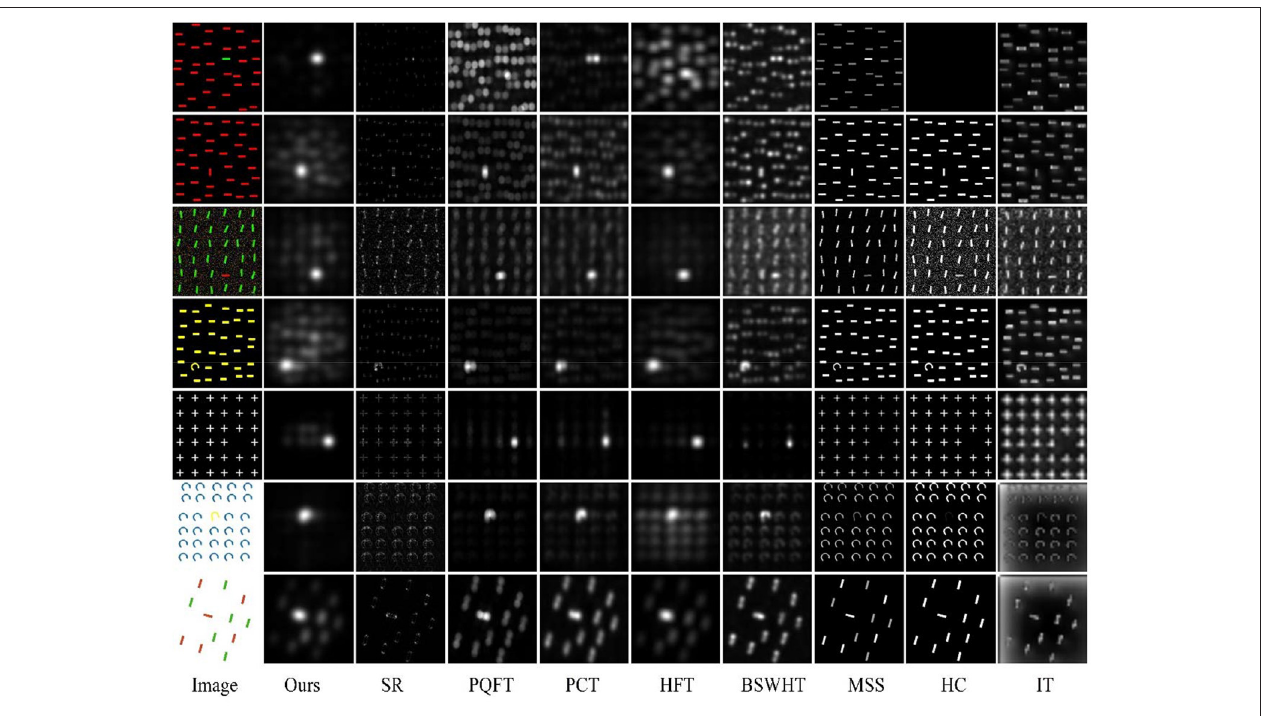
FIGURE 2 | Test on psychophysical patterns for all 9 saliency approaches.